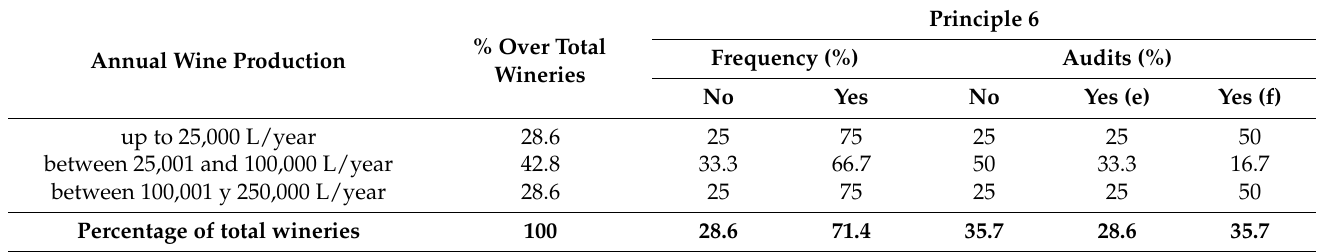
Table 6. Control frequency and audit achievements by type of winery, according to their annual wine production and by the total of the